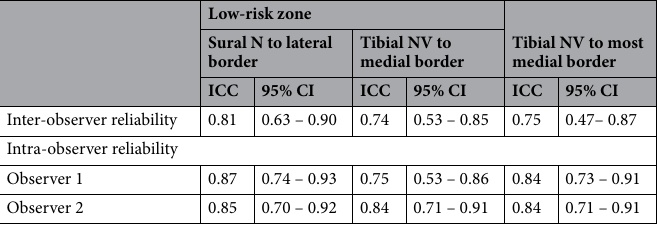
Table 2. Inter-observer and intra-observer reliability of MRI measurements. N Nerve , NV Neurovascular structure, ICC Intraclass correlation coefficient, CI Confidence